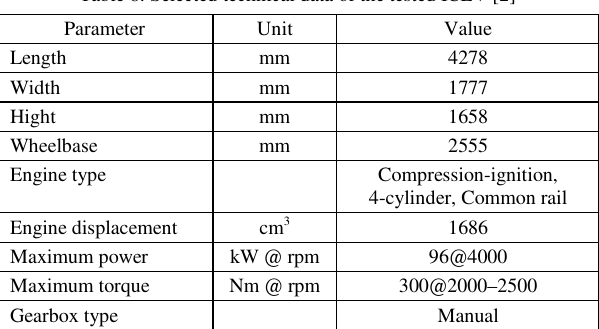
Table 8. Selected technical data of the tested ICEV [2]